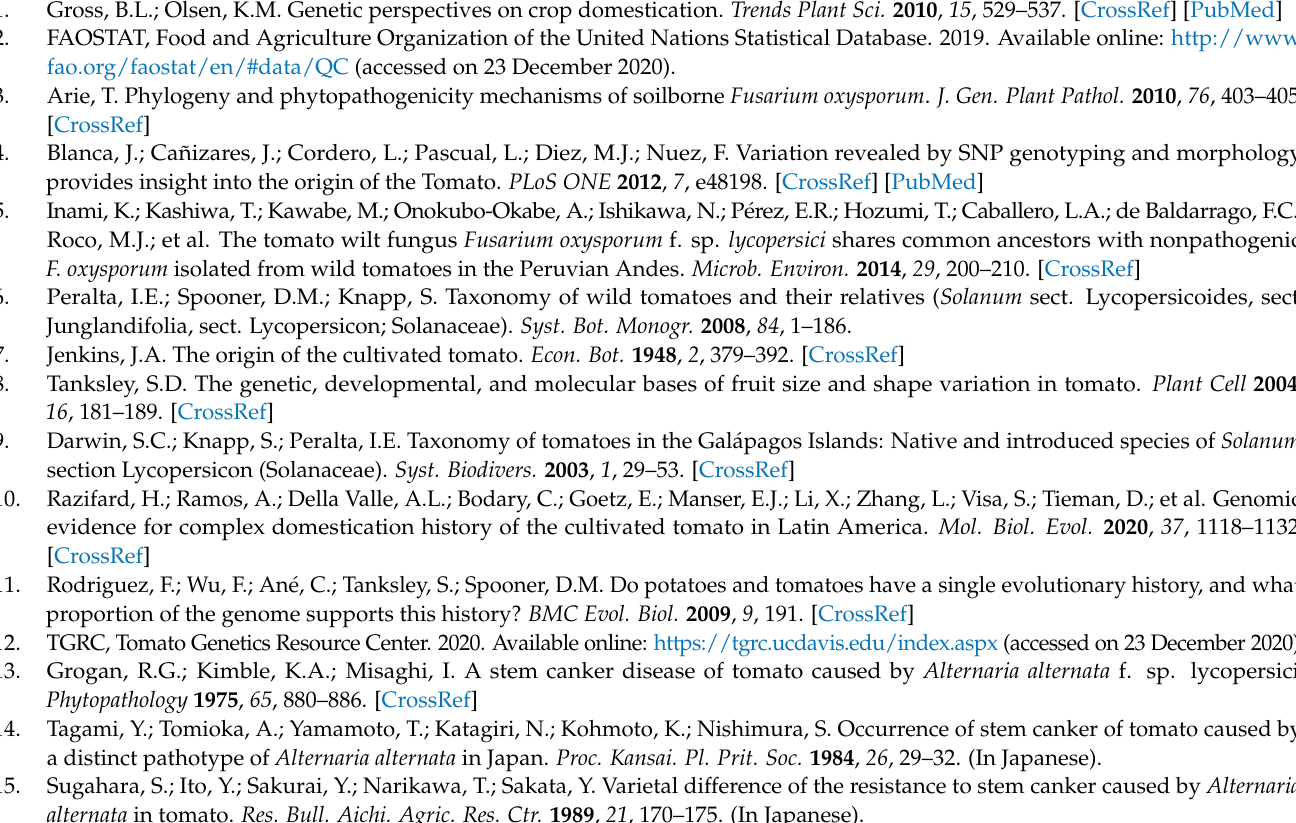
Table S1: COSII nucleotide primers used in this study referred from Rodriguez et al. 2009 [11]; Table S2: GenBank accession numbers of 18 COSII regions nucleotide sequence; Table S3: Model analysis of maximum likelihood (ML) and Bayesian inference